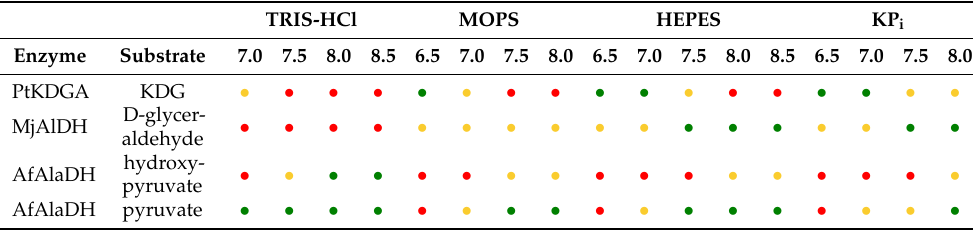
Table 2. Measured activity for the enzymes PtKDGA, MjAlDH and AfAlaDH dependent on different buffers and pH. The percentage depends on the maximum measured activity of each respective enzyme-substrate combination. 0–50% is shown in red, 51–75% in yellow and 76–100% in green. Exact reaction conditions and values for every enzyme can be seen in the Supplementary Figures